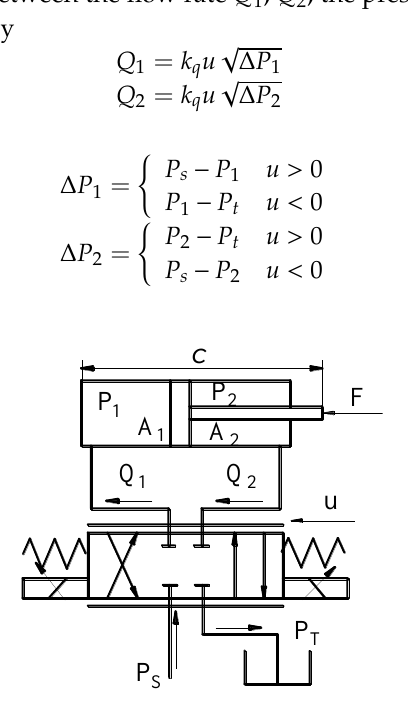
Figure 8. Hydraulic driving system schematic diagram.